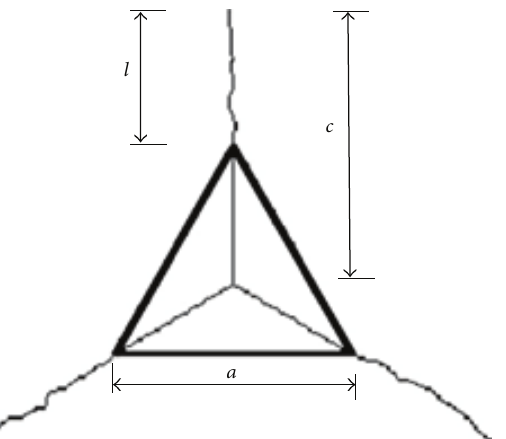
Figure 3: Schematic representation of the crack length formed at the corners of the Berkovich nanoindentation